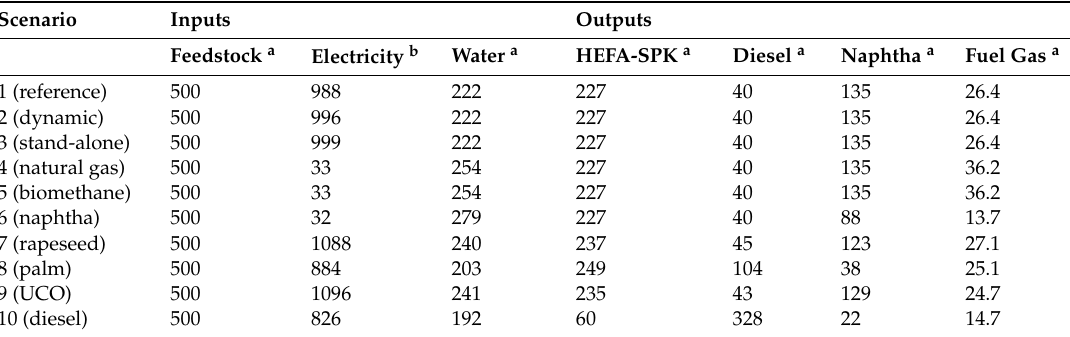
Table 4. Most important mass and energy balances for the di ff erent